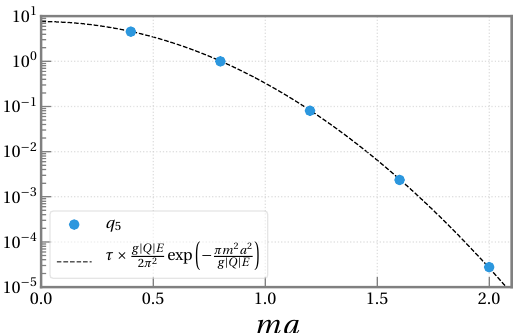
Figure 4 . Blue points show a numerical evaluation of the chiral charge q 5 as a function of the p fermion mass m . Here we have adopted a units g j Q j E = 1, and taken (cid:28) = 150. 4 For comparison, we also show the right-hand side of eq. (3.17) as a black dashed line, demonstrating excellent agreement with this analytical